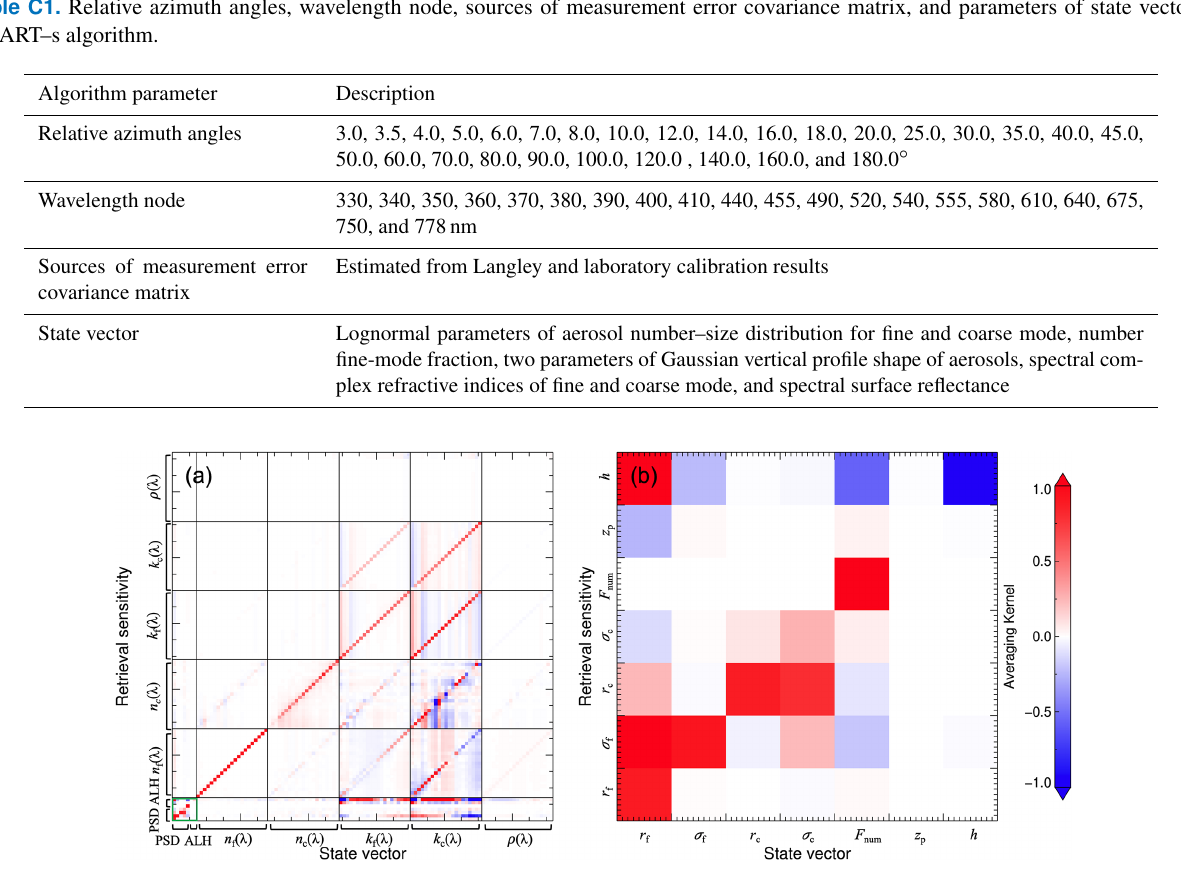
Figure C1. Averaging kernel matrix ( A ) of SMART–s retrievals at 08:31UTC on 10 April 2019 at Fang, Thailand, when fine-/coarse-mode volume fractions were comparable and aerosol single scattering albedo was about 0.87, with the aerosol optical thickness of about 1.06 at 440nm. Indices from 1 to 5 correspond to fine-mode mean radius ( r f ) and geometric standard deviation ( σ f ), and those pair for the coarse mode ( r f and σ f ) and number fine-mode fraction ( F num ). Indices 6 and 7 are the peak height ( z p ) and dispersion parameter ( h ) of the assumed aerosol extinction profile. Each element of the real ( n ) and imaginary ( k ) part of the refractive index for fine (subscript f) and coarse mode (subscript c) indicates its retrieval sensitivity at each wavelength. Panel (a) shows the whole of A , and panel (b) magnifies to the particle size distribution (PSD) and aerosol layer height (ALH) parameters (indices from 1 to 7), as indicated by a green square at the bottom left of panel (a)